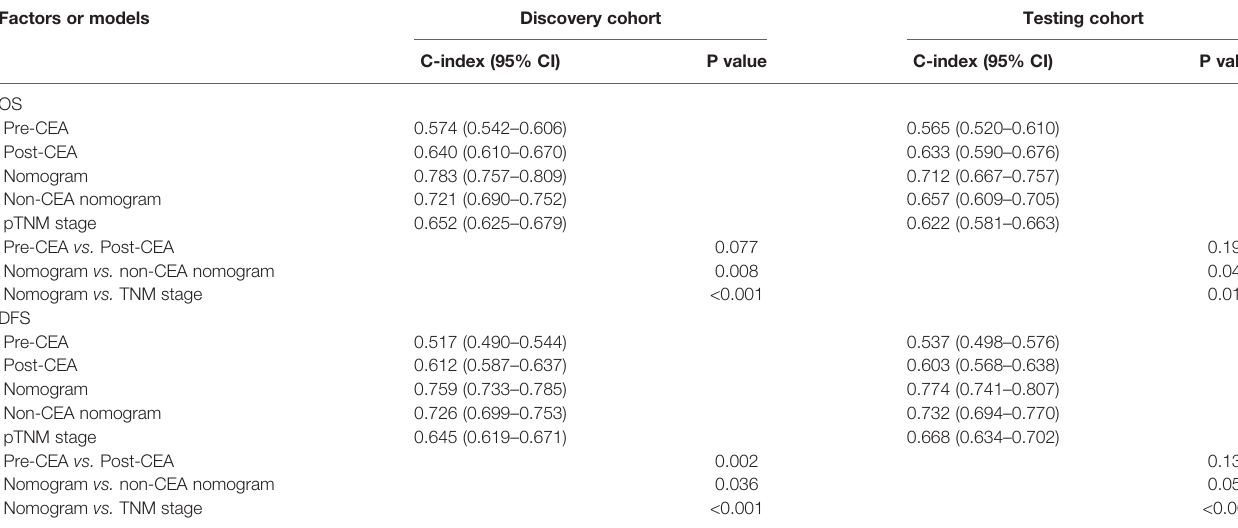
TABLE 1 | C-indexes of prognostic factors or models for predicting OS and DFS in the discovery and testing cohort. Factors or models